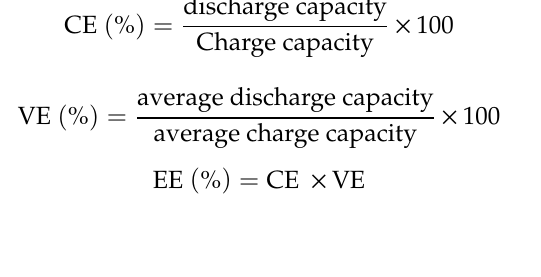
Figure 2. The 19 F-NMR spectra of poly(pentafluorostyrene) (PPFSt) and PPFSt-MTZ.